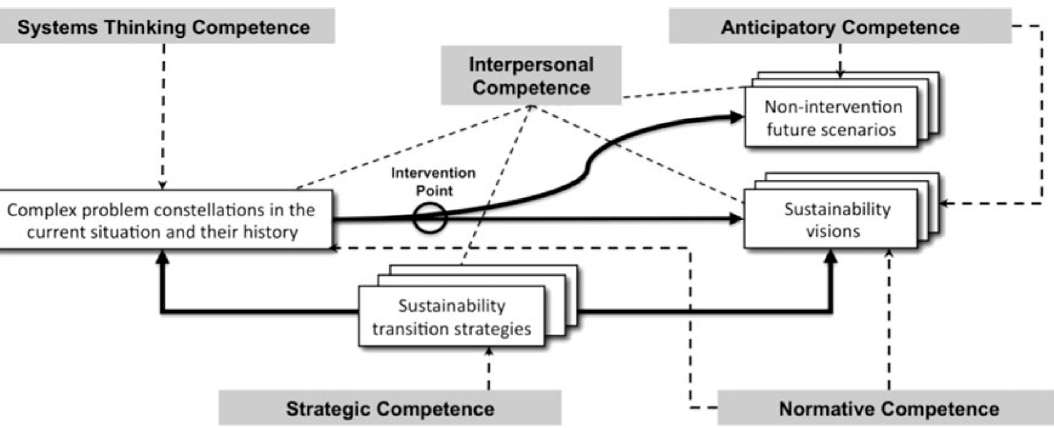
Figure 1. “The five key competencies in sustainability ( shaded in grey ) as they are linked to a sustainability research and problem-solving framework […] . The dashed arrows indicate the relevance of individual competencies for one or more components of the research and problem-solving framework […]” (Wiek et al. 2011, p. 206).